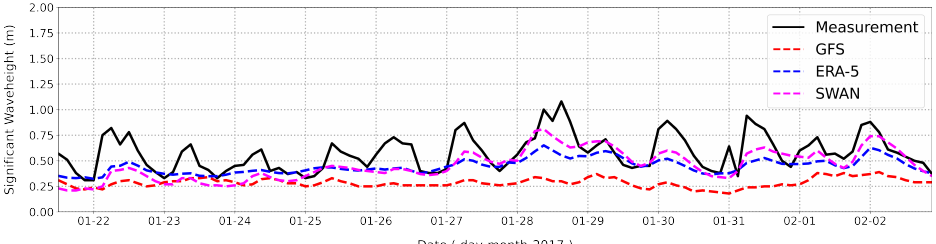
Figure 7. Location of wave observations at Jakarta Bay, Java Sea.